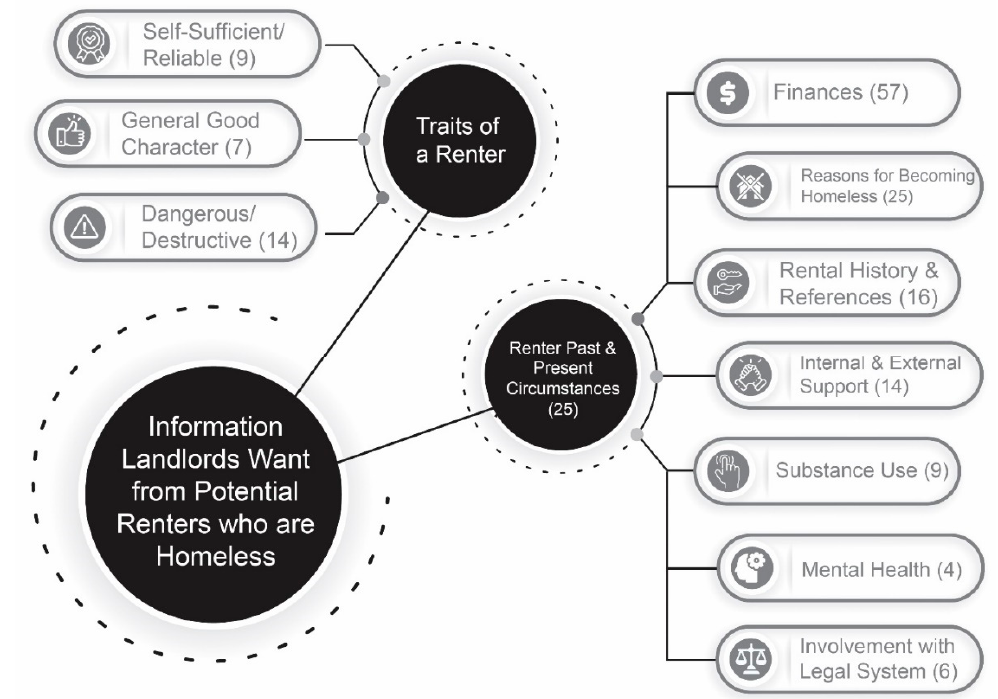
Figure 1. Coding tree . Figure 1 illustrates the coding tree created through the two-cycle coding process, with the number in the parentheses indicating how many times the code